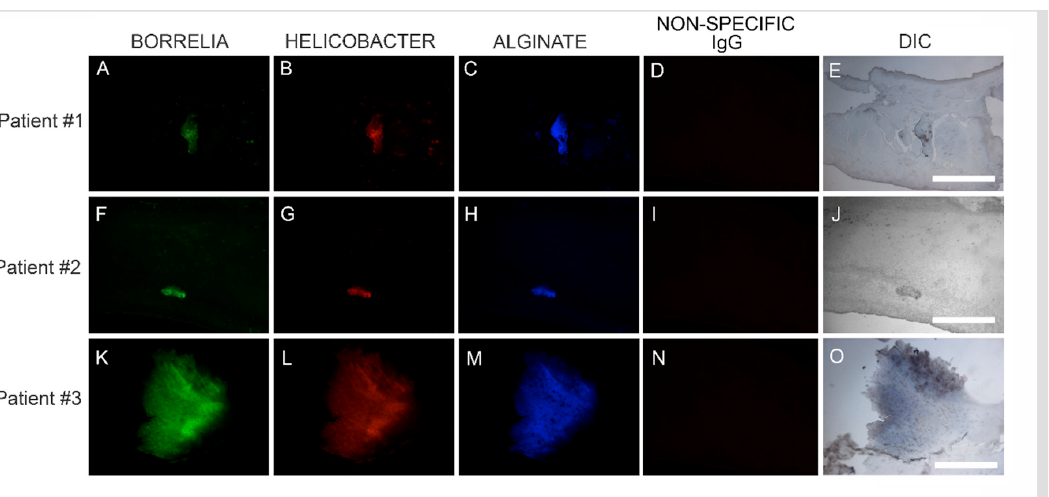
Figure 4. Representative IHC images showing biofilm aggregates in MD skin sections stained for Borrelia , Helicobacter and alginate. IHC detection was performed as described in the Methods section. Panels A, F and K show skin sections treated with anti- Borrelia monoclonal antibody (green). Panels B, G and L show skin sections treated with anti- Helicobacter antibody (red). Panels C, H and M show skin sections treated with anti-alginate antibody (blue). Panels D, I and N show negative control sections treated with non-specific IgG. Panels E, J and O show sections imaged with DIC. Images were taken at 200× magnification. Scale bar = 100 µm.